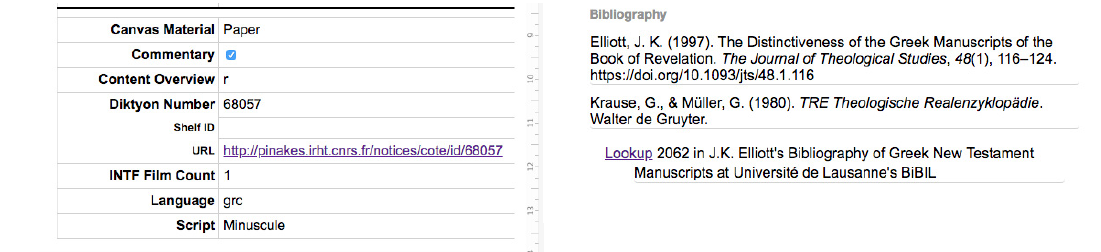
Figure 1. “Liste” Entry for GA